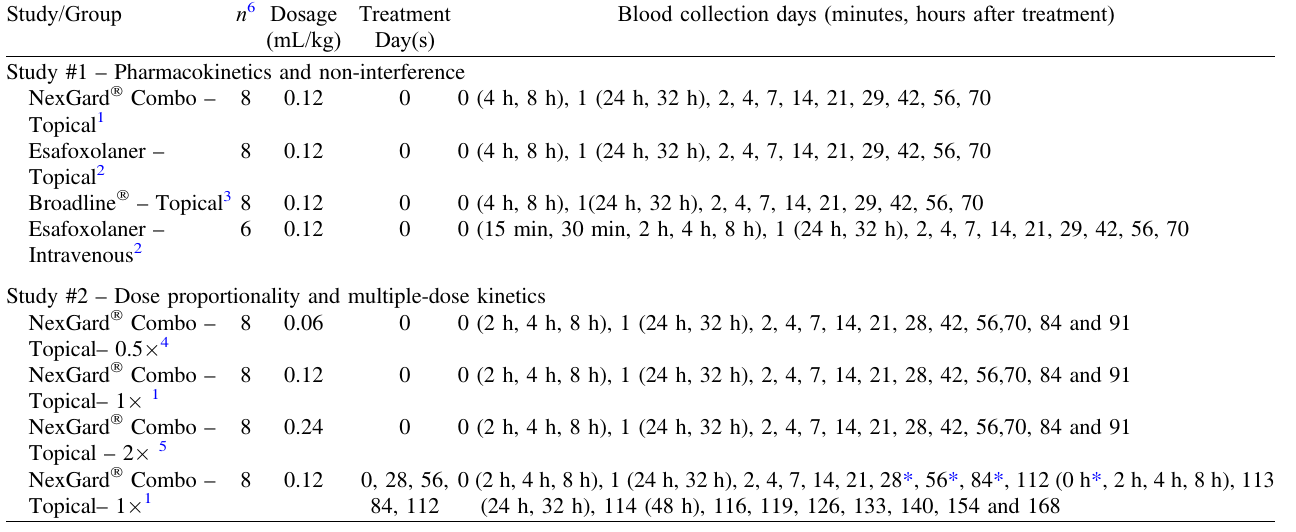
Table 1. Study designs. Study/Group